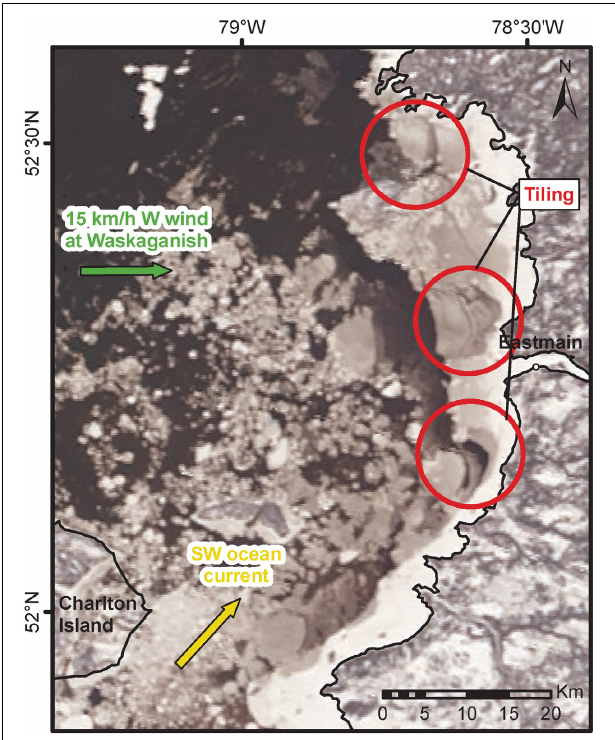
FIGURE 7 | Comparison of freeze-up dates in James Bay for 1979–1997 and 1998–2016 periods adapted from Taha et al. (2017).